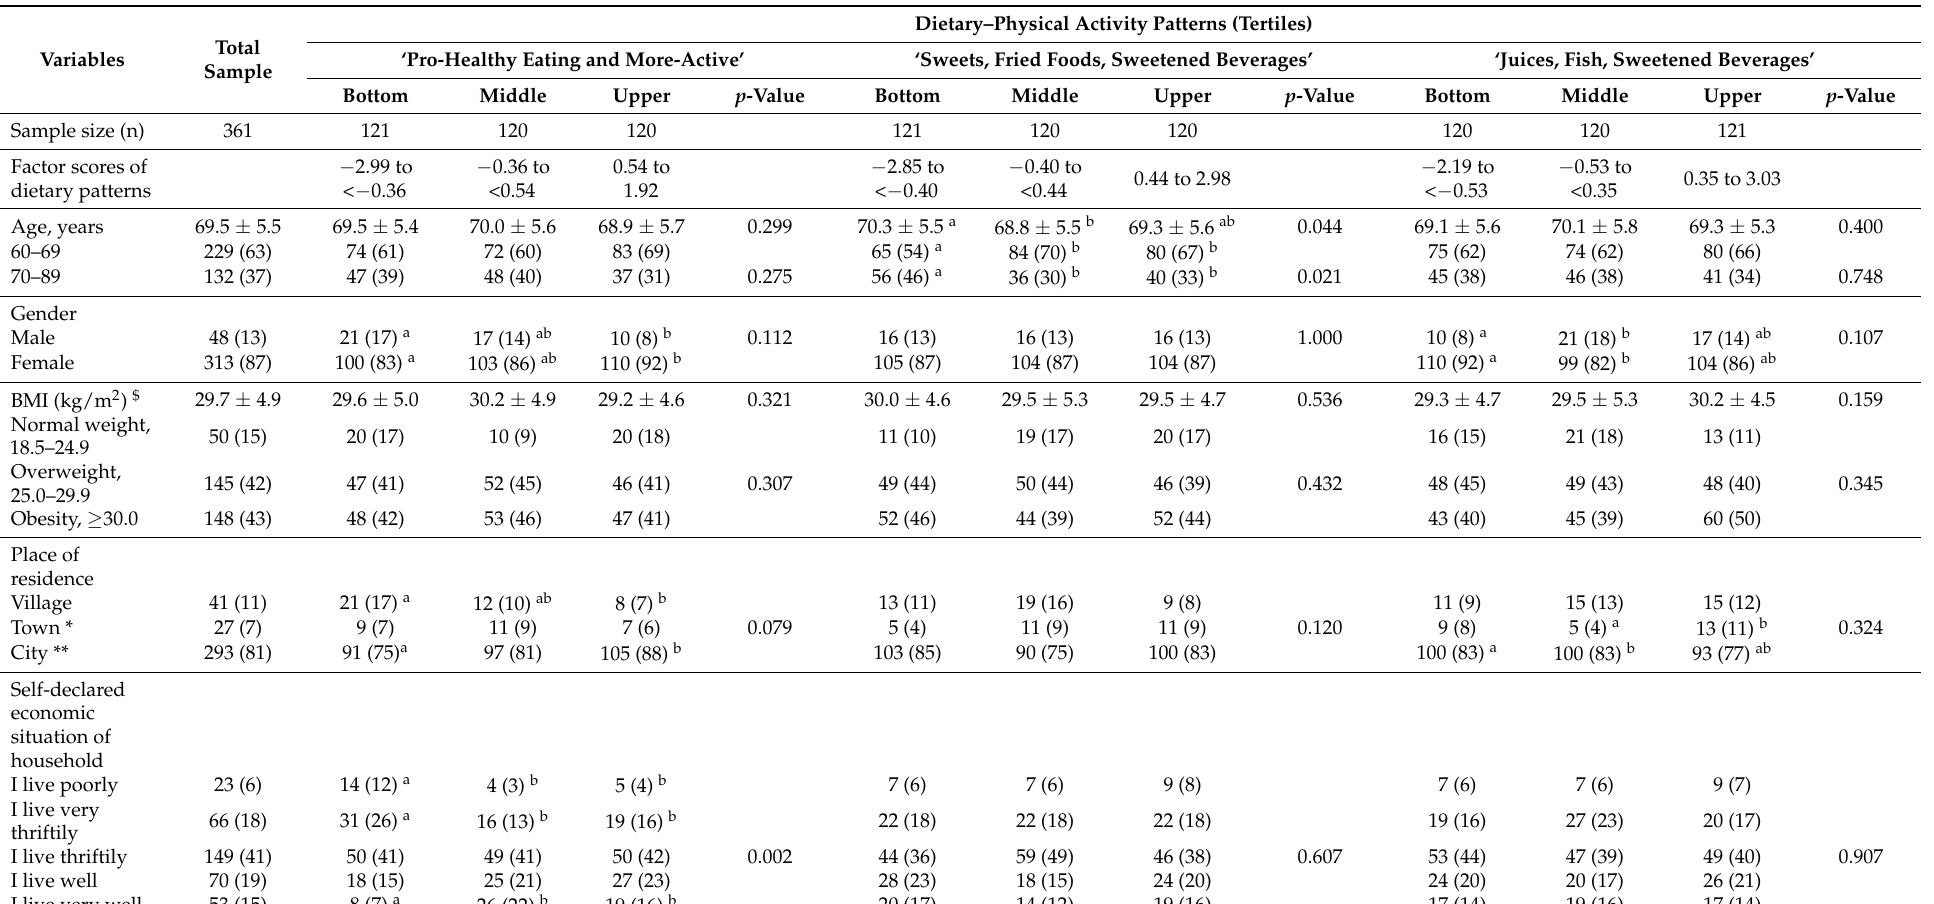
Table 4. Baseline characteristics of study sample (sample size and percentage (%) or mean ±